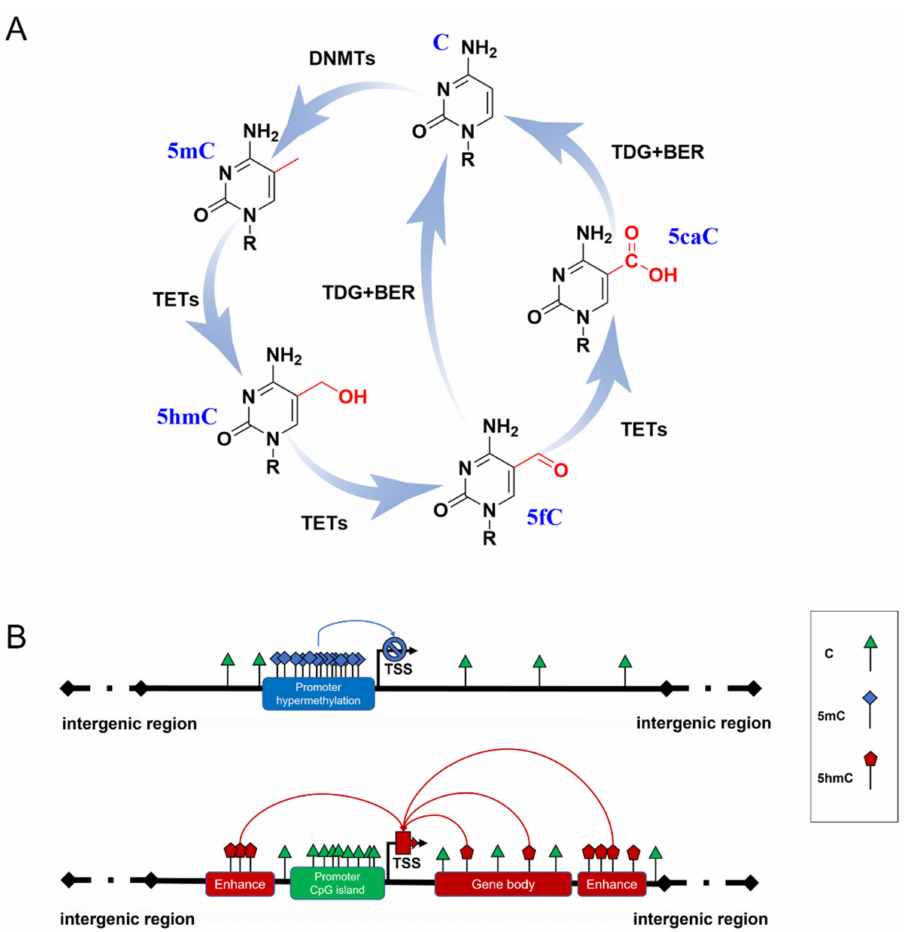
Figure 1. DNA methylation formation and regulation in gene expression. ( A ) The cycle of DNA methylation. 5mC is formed from C by the catalyzation of DNMTs; then, it can be hydroxylated to 5hmC and further oxidized to 5fC and 5CaC by TET enzymes. 5fC and 5caC are recognized by thymine DNA glycosylase (TDG), which triggers the base excision repair (BER) process, leading to the conversion to unmethylated cytosine. ( B ) Possible role of 5mC and 5hmC in gene expression. Hypermethylated 5mC at CpG islands of gene promoters generally inhibits gene transcription (blue line). 5hmC of gene enhancers and gene bodies up-regulates gene expression (red